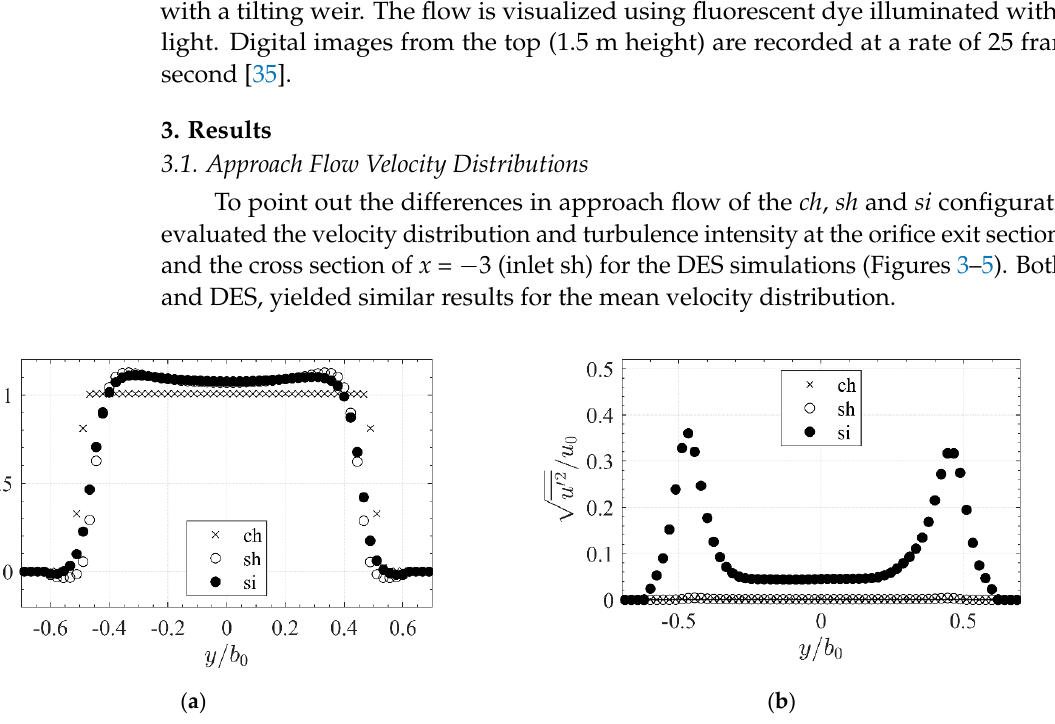
Figure 3. Lateral distributions of ( a ) mean normalized streamwise velocity 𝑢(cid:3364)/𝑢 (cid:2868) and ( b ) turbulence intensity (cid:3493)𝑢 (cid:4593)(cid:2870) (cid:3364)(cid:3364)(cid:3364)(cid:3364)/𝑢 (cid:2868) in the orifice exit section ( 𝑥 = 0 ) at 𝑧 = 0.5 ℎ (cid:2868) where 𝑢 (cid:2868) = 𝑄/𝑏 (cid:2868) ℎ (cid:2868) for configurations ch-des , sh-des , si-des . Distances 𝑦 are normalized with channel/slot width 𝑏 (cid:2868) .